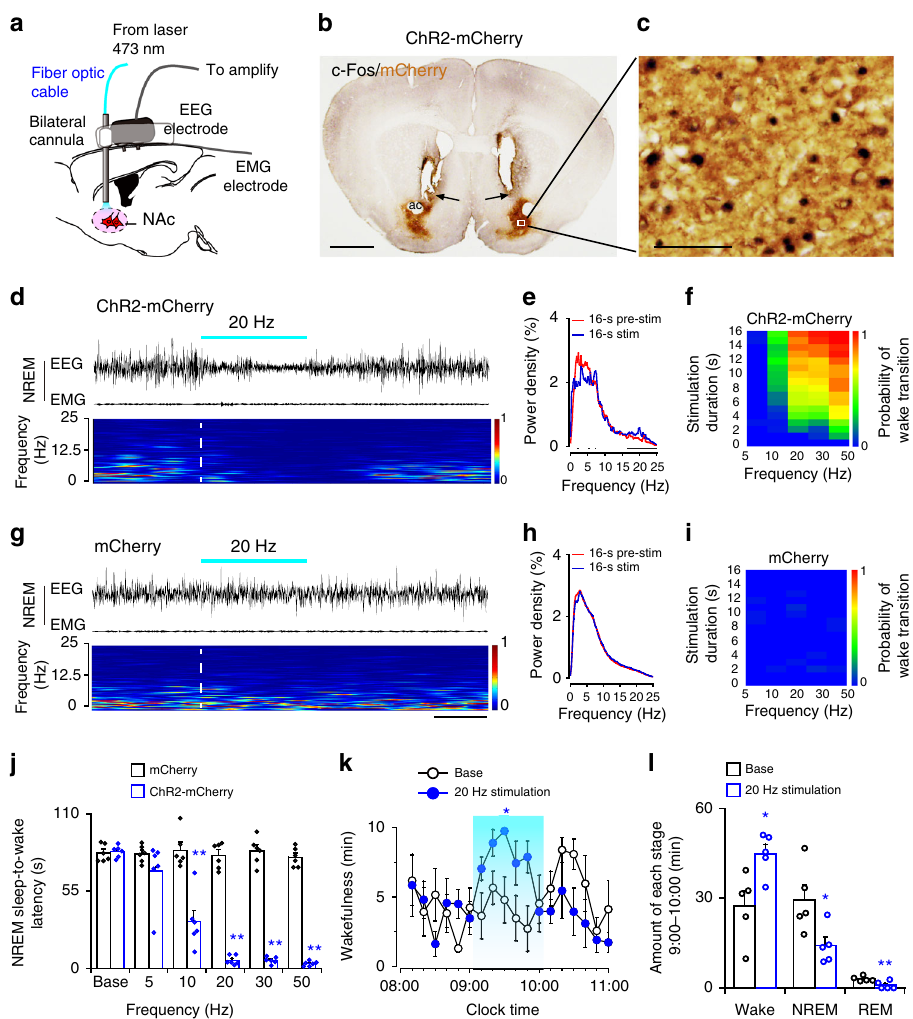
Fig. 3 Optogenetic activation of NAc D 1 R neurons induces a rapid transition from NREM sleep to wakefulness. a Diagram of experiment for in vivo optical stimulation. b Brain section was stained against mCherry and c-Fos to con fi rm that the ChR2 protein was expressed in the NAc, and arrows indicate the tip of the optical fi ber above the NAc. Scale bar: 1 mm. c Higher magni fi cation image of white box in ( b ) indicates abundant c-Fos immunoreactivity in ChR2- mCherry neurons following photostimulation. Scale bar: 50 μ m. d , g Representative EEG/EMG traces, heat map of EEG power spectra show that acute photostimulation (20 Hz/5 ms) applied during NREM sleep induced a transition to wake in a ChR2-mCherry mouse. Scale bar: 8 s. e , h EEG power (mean) before (red trace) and after (blue trace) onset of photostimulation in ChR2-mCherry ( e ) or mCherry ( h ) mice. Gray lines indicate statistical differences ( n = 5 per group; P < 0.05, paired t test). f , i Heat maps showing the mean probability of NREM sleep-to-wake transitions induced by photostimulation in ChR2-mCherry ( f ) or mCherry ( i ) mice, n = 5 per group. Quanti fi cation based on an average of 6 – 12 stimulations per condition per mouse. Stim stimulation. j Latencies of transitions from NREM sleep to wakefulness after photostimulation at different frequencies ( n = 6 per group, unpaired t test; Base, t 10 = 0.4, P = 0.7; 5 Hz, t 10 = 1.3, P = 0.2; 10 Hz, t 10 = 5.5, P = 3 × 10 − 4 ; 20 Hz, t 10 = 18.8, P = 4 × 10 − 9 ; 30 Hz, t 10 = 19.5, P = 3 × 10 − 9 ; 50 Hz, t 10 = 26.4, P = 1 × 10 − 10 ). k Time course of wakefulness during semi-chronic optogenetic experiment (20 Hz/5 ms, 10 s on/20 s off). The blue column indicates the photostimulation period of the stimulation group ( n = 5, repeated-measures ANOVA; F 1,8 = 10.5, P = 0.01). l Total amounts of each stage in control and photostimulation groups ( n = 5, paired t test; t 4 = 3.7 (wake), 3.5 (NREM), 5.0 (REM); P = 0.02 (wake), 0.03 (NREM), 0.007 (REM)). Data represent mean ± s.e.m. * P < 0.05, ** P <